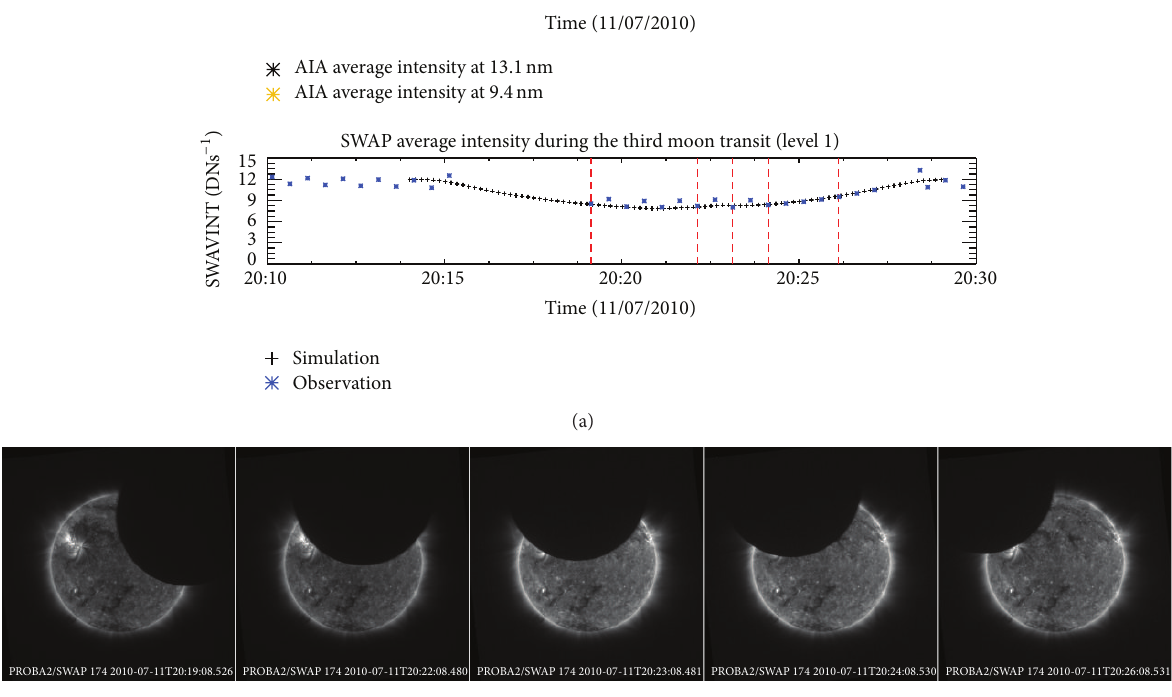
Figure 10: LYRA level 1 data measured by all four channels of unit 2, measured and simulated SWAVINT, and simulated AIA average intensity variations during the third transit of the Moon (a) together with certain SWAP images taken during the third transit of the Moon (b) whose times of observation are indicated in vertical lines on the